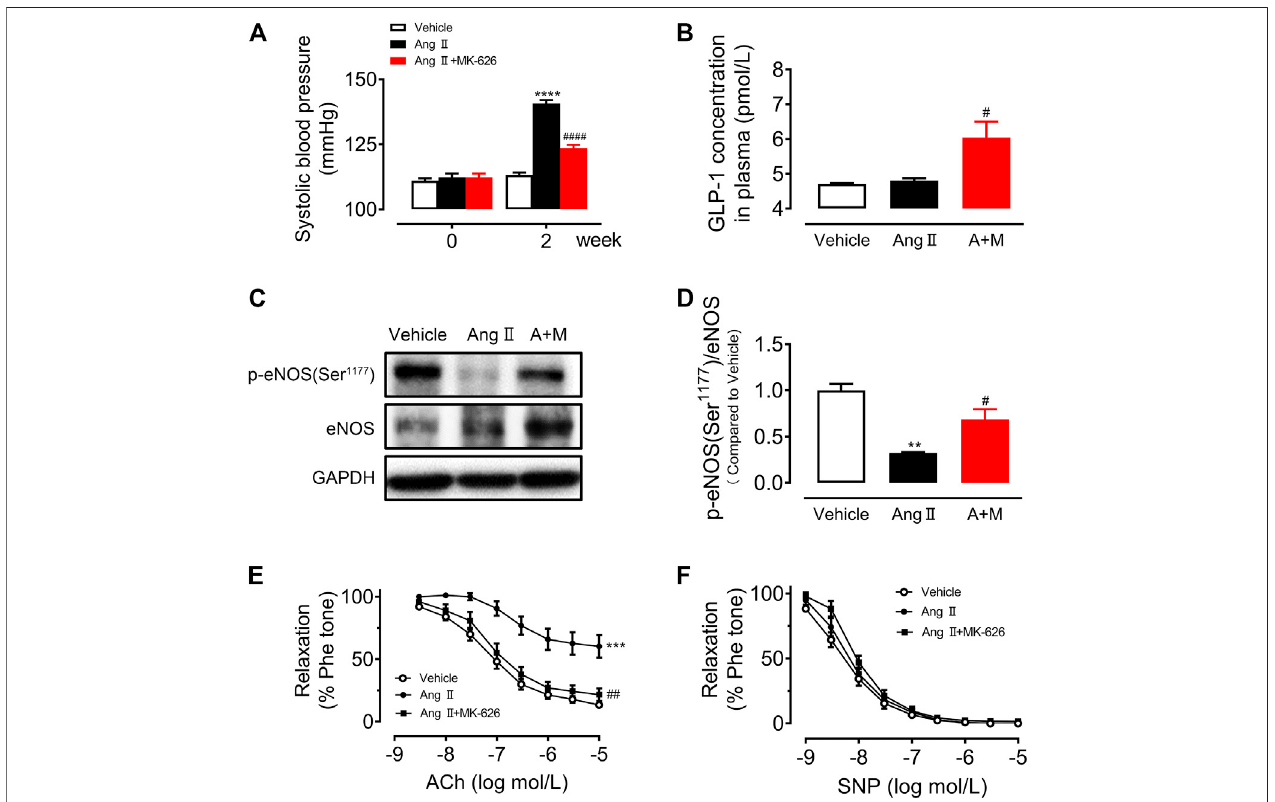
FIGURE 1 | MK-626 decreases systolic blood pressure and improves aortic endothelial dysfunction in Ang Ⅱ -induced hypertensive mice. (A) Systolic blood pressure in Vehicle, Ang Ⅱ and Ang Ⅱ + MK-626 co-treatment mice. (B) GLP-1 levels in mouse plasma. (C – D) Levels of eNOS phosphorylation and expression in the mouse aortae. ACh-induced endothelium-dependent relaxations ( E ) and SNP-induced endothelium-independent relaxations (F) in the aortae from mice. ** p < 0.01, *** p < 0.001, **** p < 0.0001 vs Vehicle; # p < 0.05, ## p < 0.01, #### p < 0.0001 vs Ang Ⅱ .Dataare expressed asmean ± SEM( n (cid:1) 4forWesternblot, n (cid:1) 5 – 7forother experiments). A + M, Ang Ⅱ +